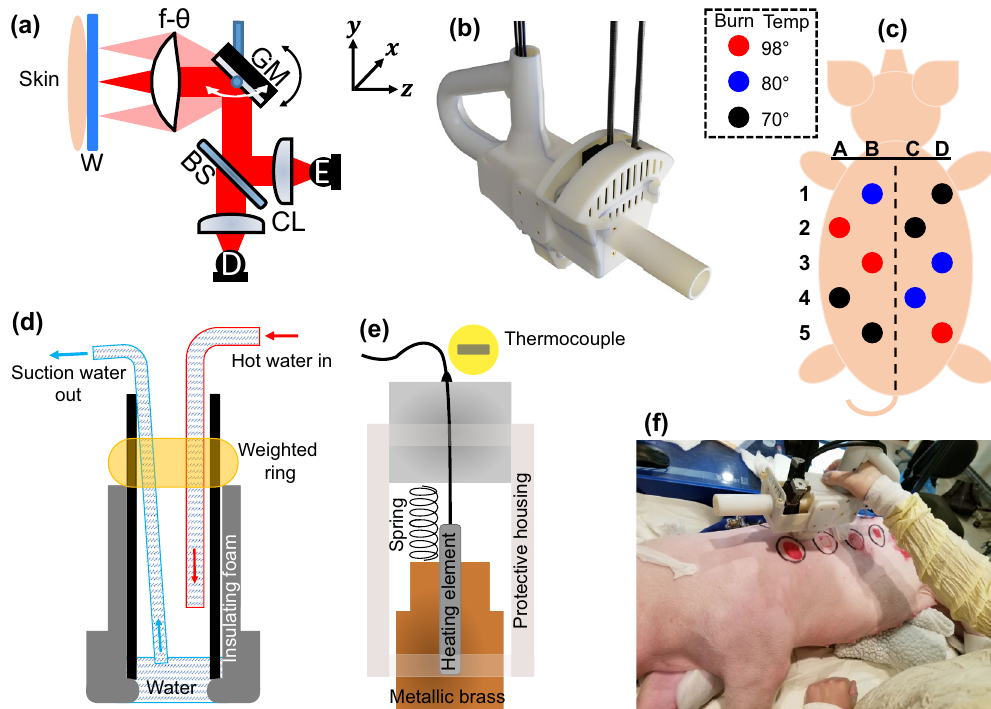
Figure 1. ( a ) The optical components inside the handheld housing (W: imaging window, GM: gimbaled mirror, BS: beam splitter, CL: collimating and refocusing lenses, E: emitter PCA, D: detector PCA), the black and white arrows show the mirror movement in y and x directions, respectively, ( b ) the 3D-printed handheld housing 3 (dimensions: 37.3 × 14 × 25.1 cm ), ( c ) the pattern of the distribution of the burn temperature on the dorsal side of the subject, ( d – e ) the side view schematics of the scald and contact devices designed for burn induction, respectively, ( f ) demonstration of in vivo THz spectroscopic imaging of burn injuries using the PHASR Scanner.